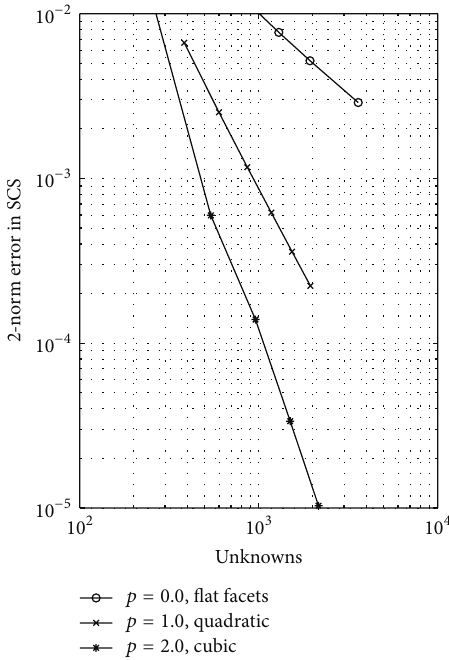
Figure 2: Error in the SCS versus number of unknowns for a sphere with 𝑘𝑎 = 2𝜋 ,obtainedfromtheMFIEwithGalerkintesting.Results arereportedforflat-facetedmodelsusedinconjunctionwith 𝑝 = 0.0 basis and test functions, quadratic-curved models used with 𝑝 = 1.0 functions, and cubic-curved models used with 𝑝 = 2.0